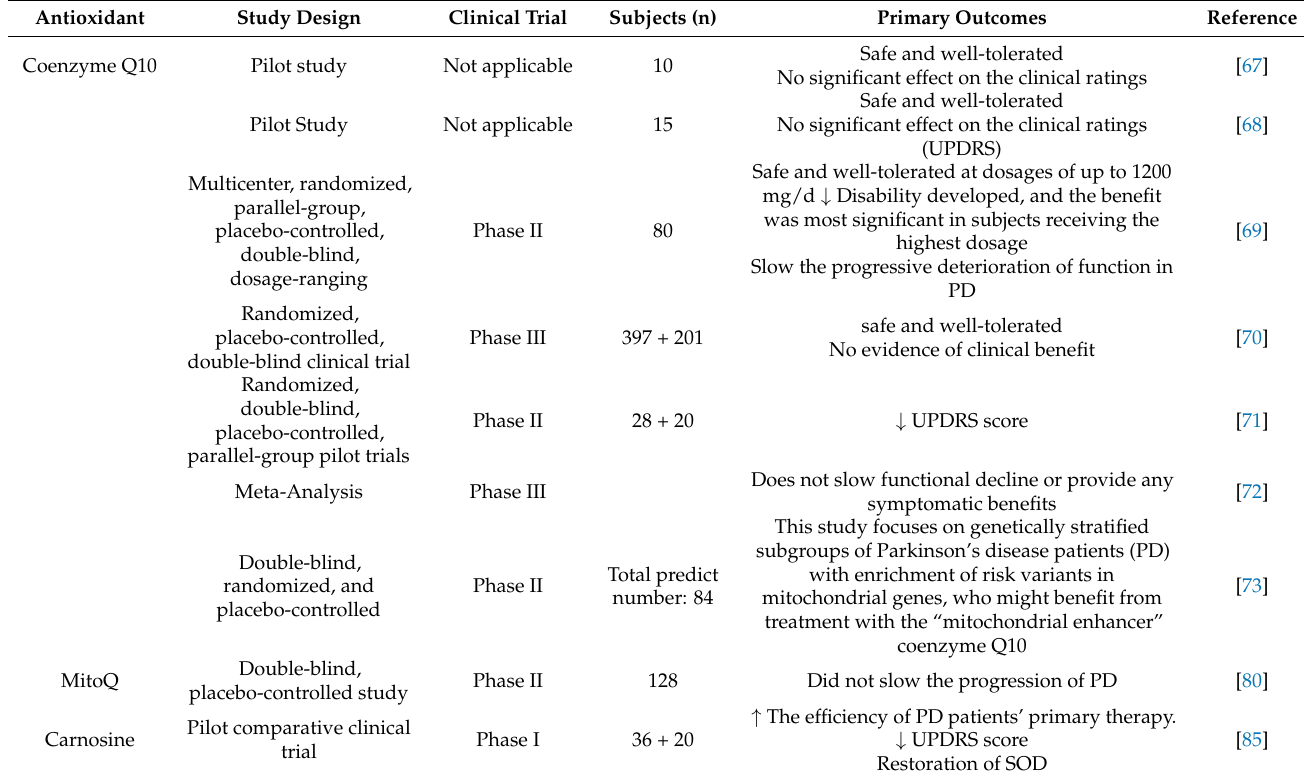
Table 1. Summary of mitochondrial antioxidants effect on PD clinical